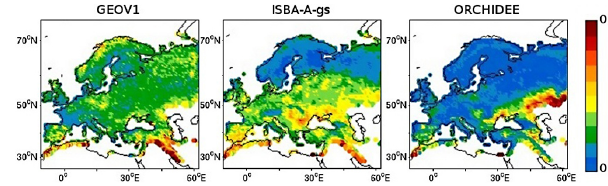
Figure 11. Annual coefficient of variation (ACV) of LAI over the 1991–2008 period (left, GEOV1; middle, ISBA-A-gs; right, OR-